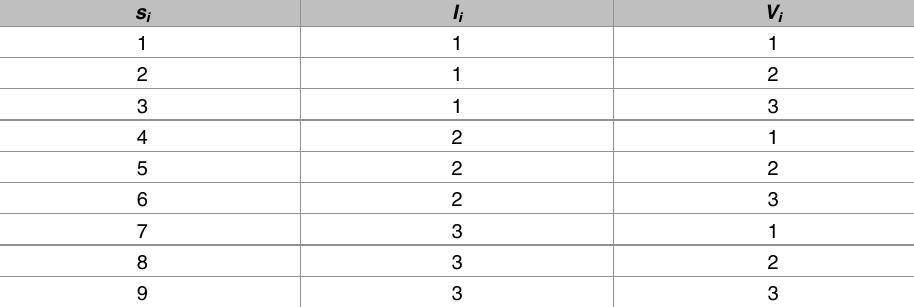
Table 4. Encoding of the 9 possible states when field i is a wheat field.